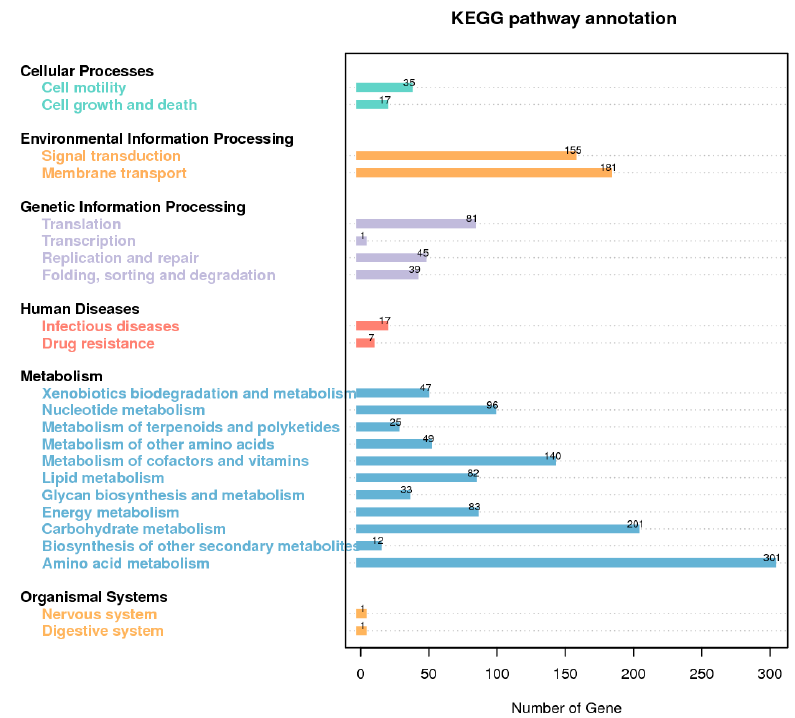
Figure 8. Kyoto Encyclopedia of Genes and Genomes (KEGG) database metabolic pathway classification map of GW13 genome.